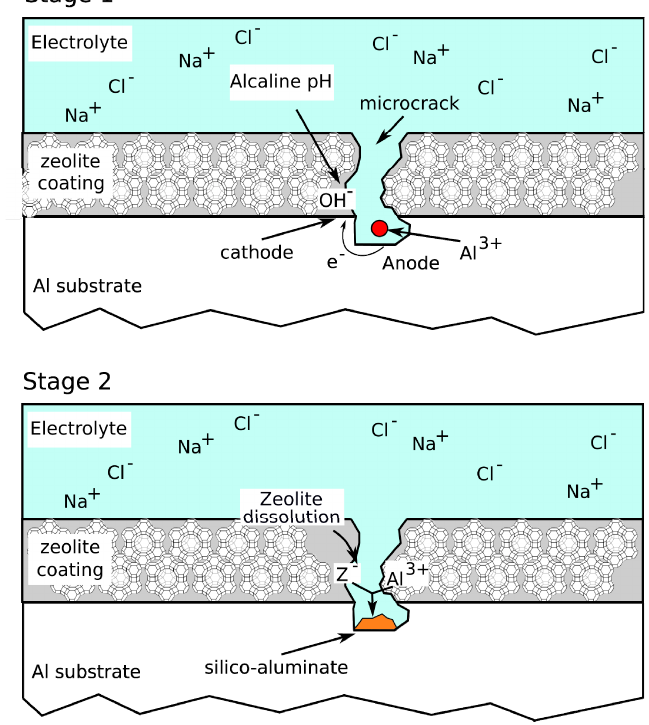
Figure 9. Scheme of corrosion protection on defected areas of zeolite based coatings.